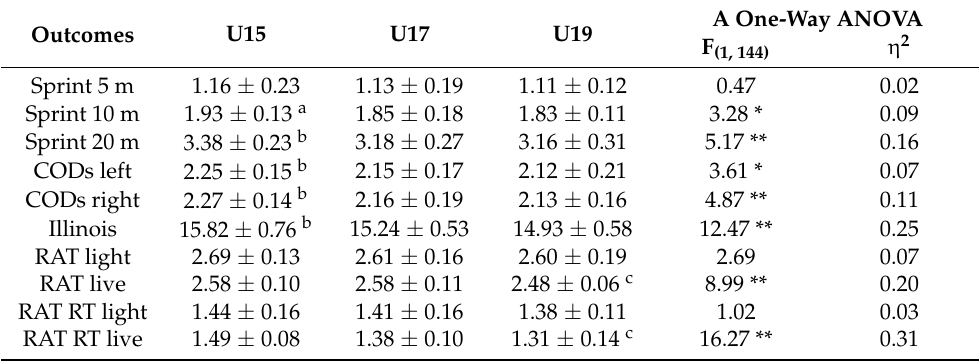
Table 2. Times for 5 m, 10 m sprint, and 20 m sprint, and agility performance for the U15 ( n = 25), U17 ( n = 27), and U19 ( n = 23) soccer